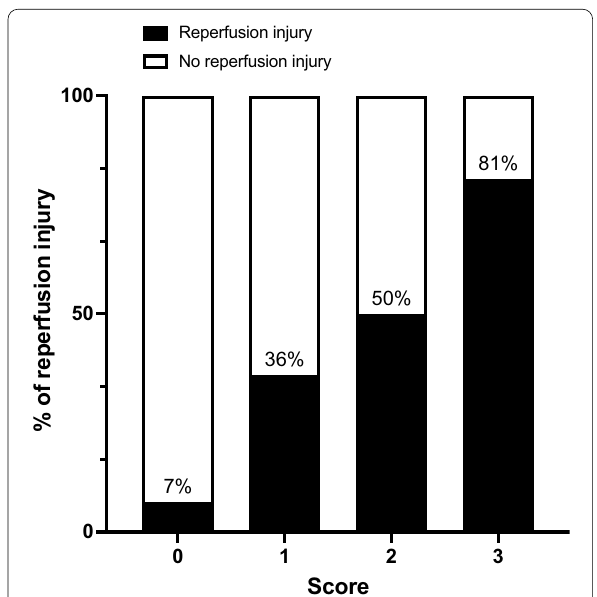
Fig. 4 Rate of reperfusion injury after revascularization according to the computed tomography score. The score includes the presence of a decreased enhancement of the bowel wall on pre-treatment CT, an embolic as the cause of the mesenteric ischemia, and complete occlusion of the superior mesenteric artery (each equally graded as